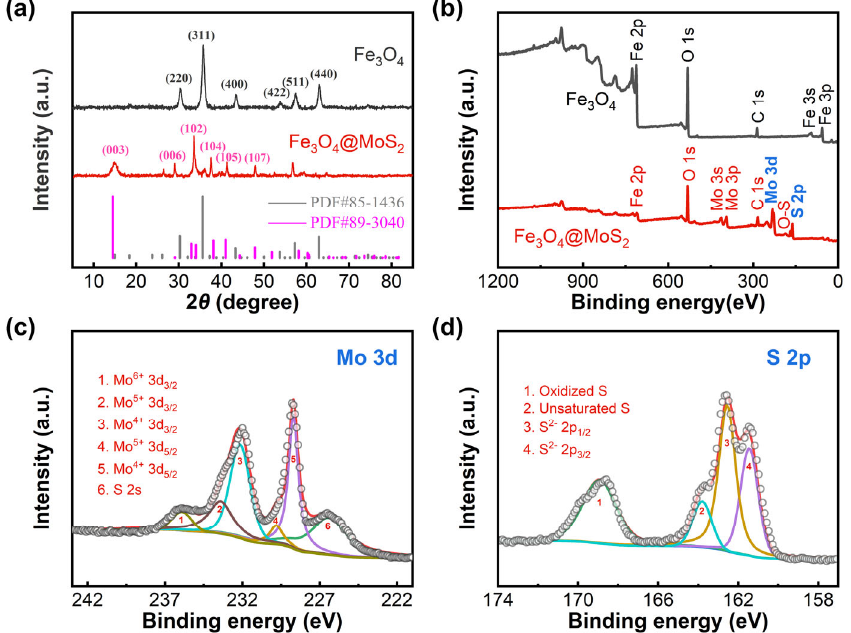
Figure 2. ( a ) XRD patterns of Fe 3 O 4 and Fe 3 O 4 @MoS 2 ; ( b ) survey scans of the XPS spectra of Fe 3 O 4 and Fe 3 O 4 @MoS 2 ; XPS spectra of ( c ) Mo 3d, and ( d ) S 2p in Fe 3 O 4 @MoS 2 (peaks are numbered